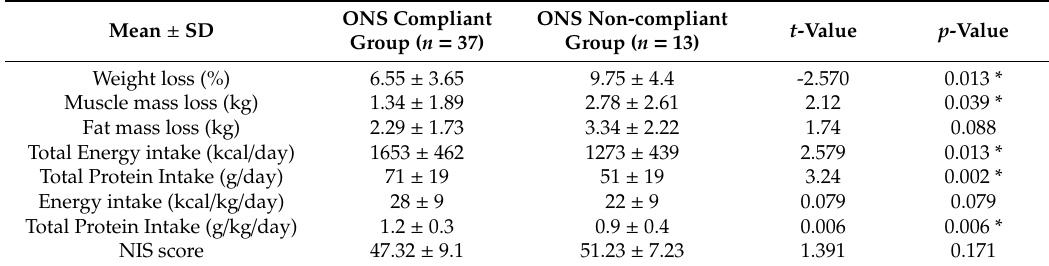
Table 5. Weight, muscle, and fat loss, total energy and protein intake, and NIS score according to the ONS compliant group.